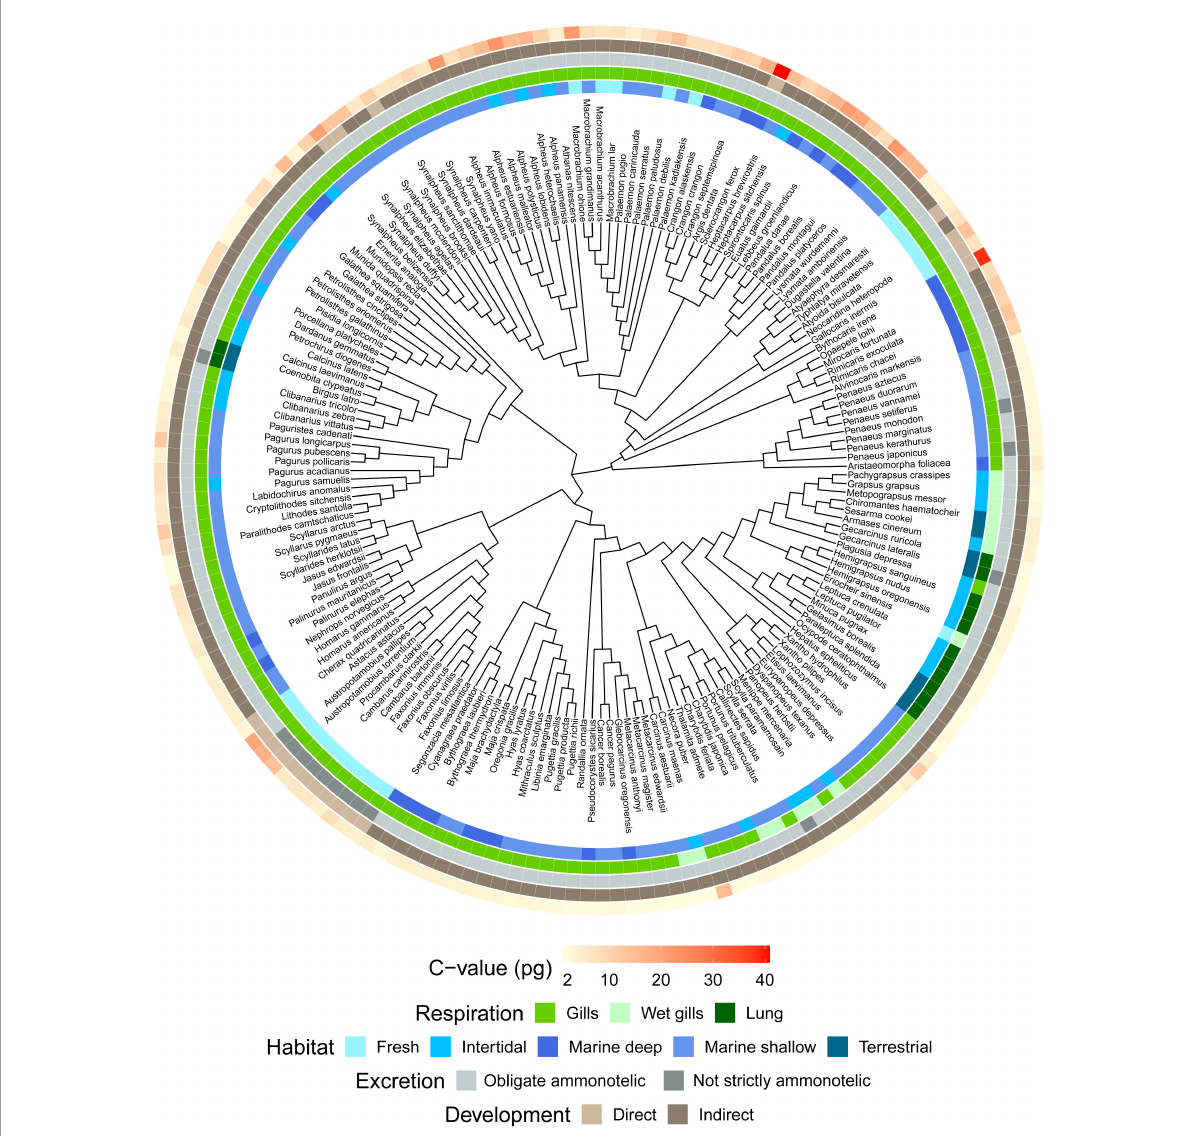
FIGURE1 Taxonomy-based dendrogram of decapods with known genome size ( n = 179). C -values are shown in red gradient (minimum/light red = 1.16 pg, maximum/dark red = 40 pg). Specific C -values are reported in Supplementary Table 1 . Differences in habitat, respiration and developmental mode are also plotted on the dendrogram using different